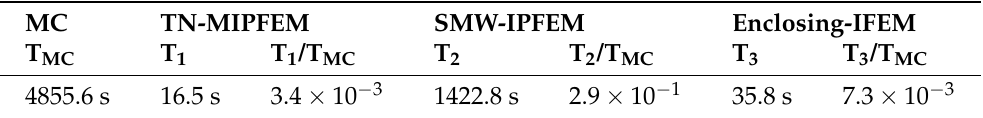
Table 2. The total calculation time by 10,000 MC, TN-MIPFEM, SMW-IPFEM, and enclosing-IFEM for 3D classical vibro-acoustic coupling